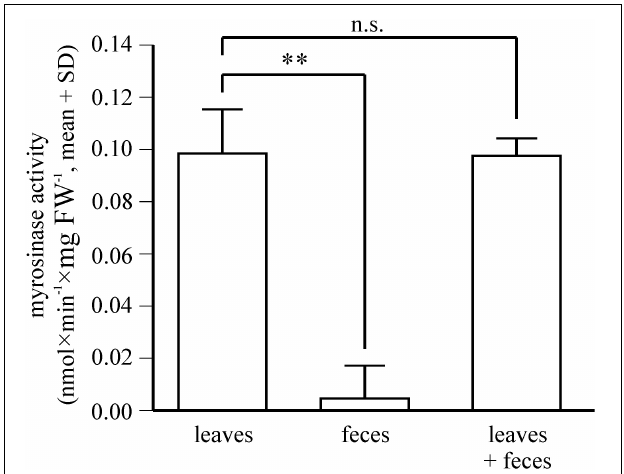
FIGURE 6 | Fate of ingested plant myrosinase activity in P. armoraciae . Levels of soluble plant myrosinase activity were analyzed in extracts prepared from intact Arabidopsis myb leaves and in the corresponding amount of digested leaf material (feces). In addition, plant myrosinase extracts were co-incubated with the corresponding feces extract ( n = 5–6 per treatment). Myrosinase activity was determined by adding 4MSOB glucosinolate to each sample. After 30 min incubation, the reaction was stopped by boiling. Remaining glucosinolate substrate was quantified by LC-MS/MS. Myrosinase activity in intact leaves was compared with that in digested leaves and in the co-incubation treatment by paired Student’s t -tests, respectively ( ∗∗ p < 0.005; n.s., p > 0.05). Results of statistical analyses are shown in Supplementary Table 1